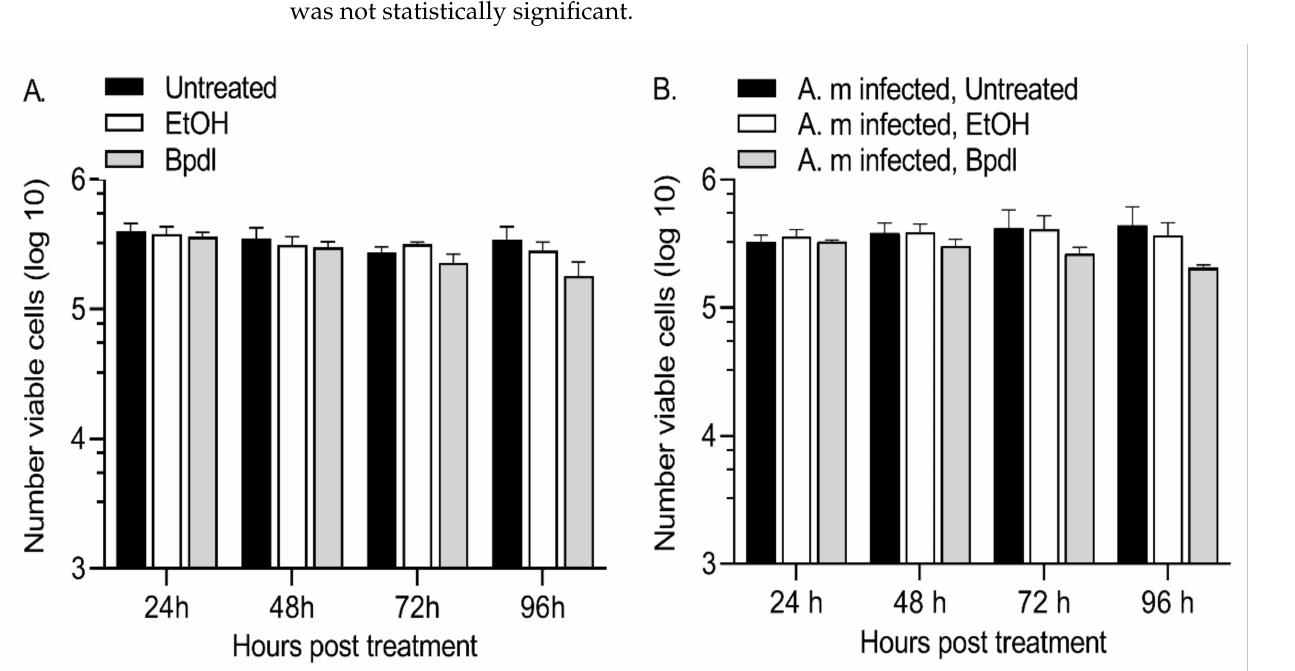
Figure 1. Minimal cell death in response to Bpdl treatment. There were minimal differences in the number of live cells following Bpdl treatment in uninfected ( A ) and A. marginale -infected ( B ) DAE100 cells. DAE100 cells received L15B complete medium (untreated), the carrier (EtOH), or 100 µ M Bpdl. The number of viable cells was measured using trypan blue staining with three independent replicates. The bars represent the average ± standard error of the mean